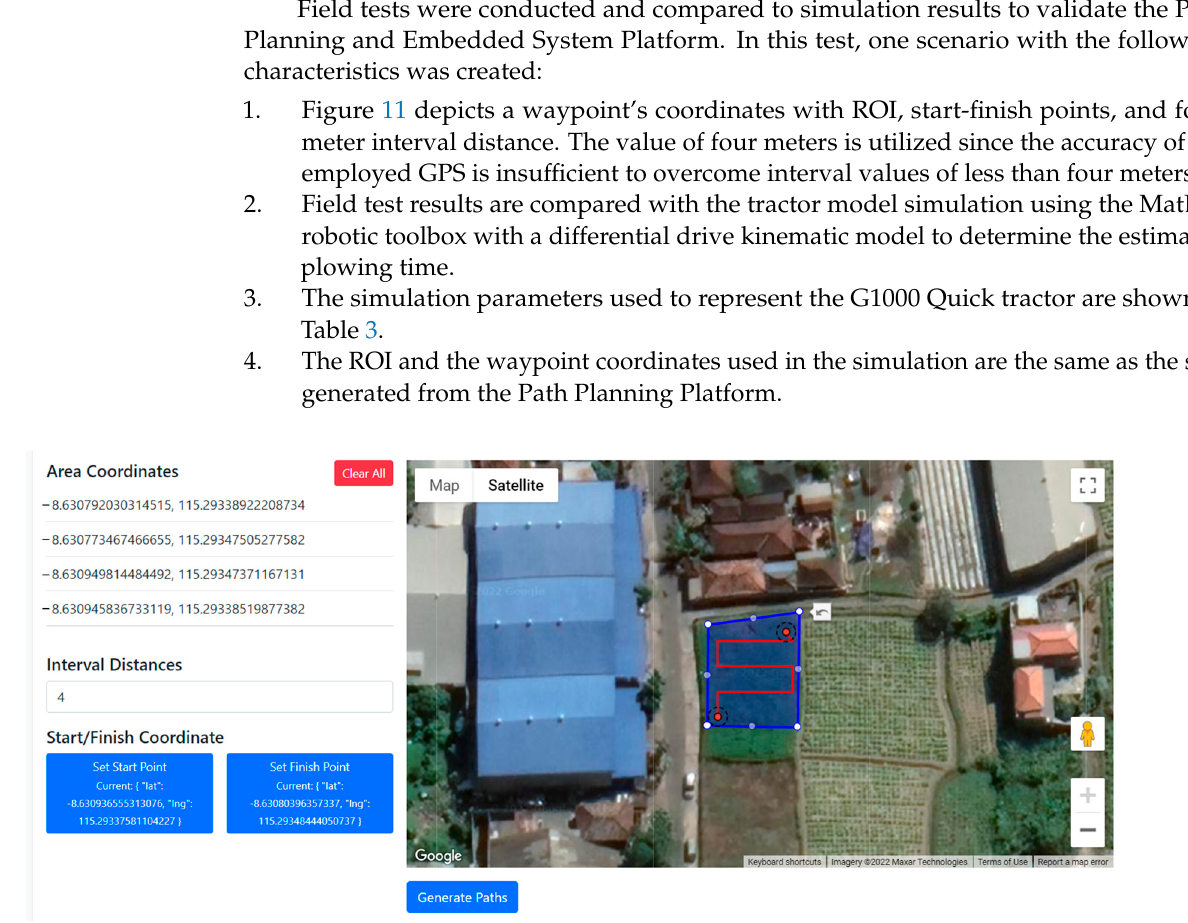
Figure 10. Tractor heading error.